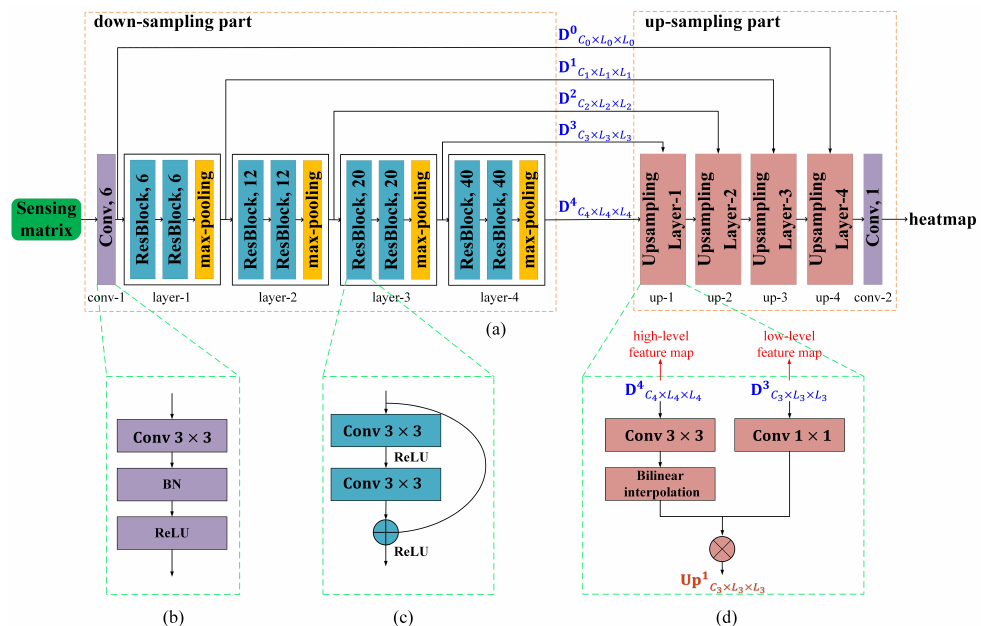
Figure 4. ( a ) MSLocNet structure; ( b ) convolution module; ( c ) ResBlock structure; ( d ) Upsampling layer structure (we observe that a five-layer model produces good results and tried adding more layers, but it did not lead to significant